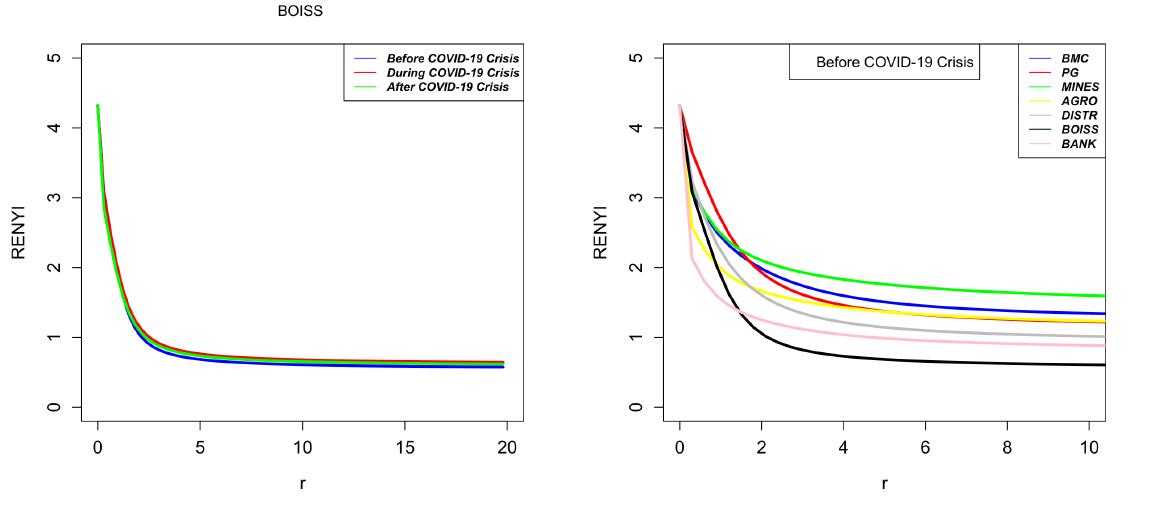
Figure 8. Rényi entropies versus scale r during the pre-crisis period for all indices